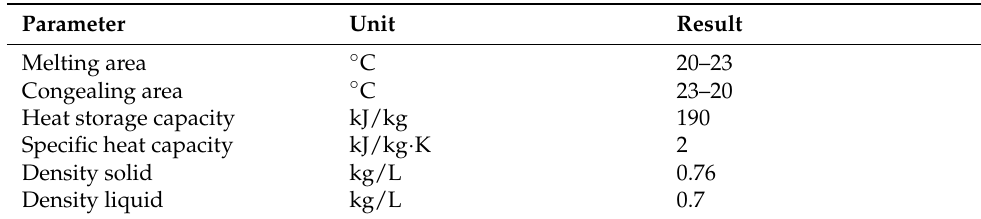
Table 1. Main parameters of Rubitherm RT22HC paraffin.